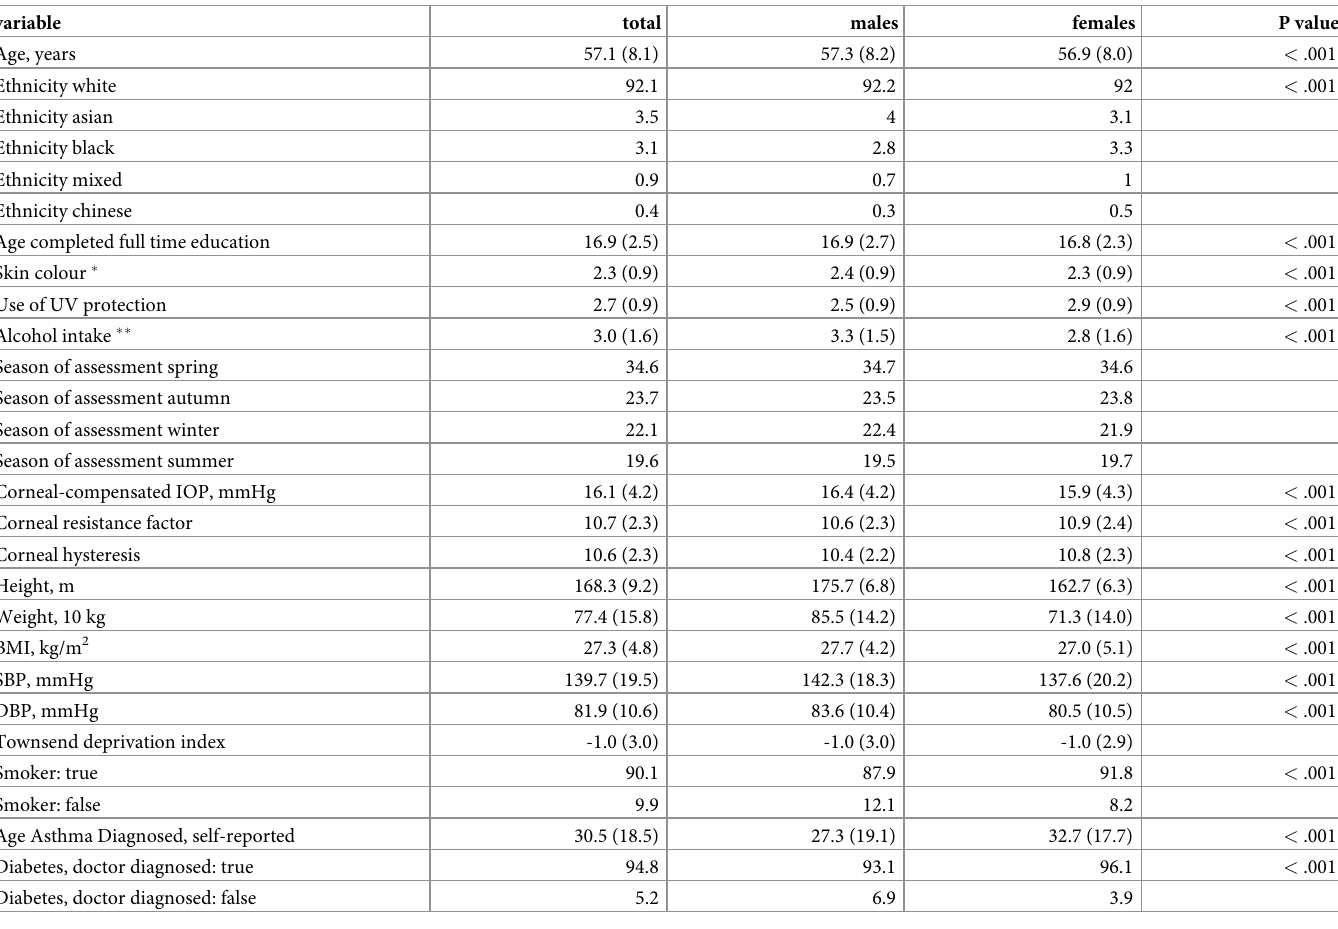
Table 1. Distribution of participants in the UKBB across the different variables. Mean/sd or percentage of the 83,751 study participants in the UKBB by sex. P values estimated by a t-test for continuous variables and chi-squared test for categorical variables in order to determine whether there is a systematic difference between males and